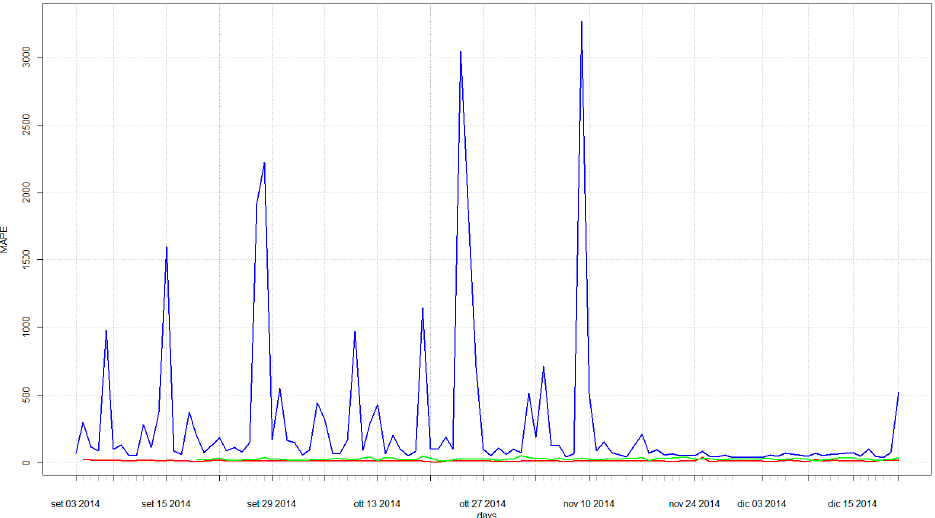
Figure 10. Mean Absolute Percentage Error (MAPE) over the observation period for the three cases (red, blue and green are residential, non-residential and non-residential mixed customers, respectively).